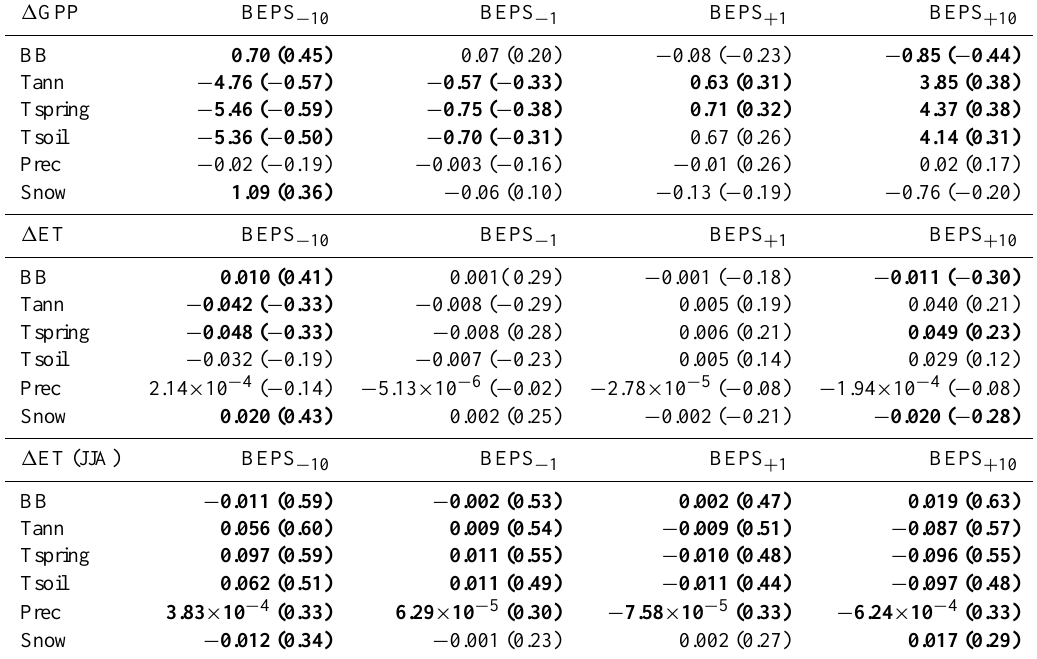
Table 5. Slope of the linear regression analysis computed between 1 GPP, 1 ET and summertime 1 ET (from June to August) and different meteorological variables. In parentheses the Pearson’s correlation coefficient is reported. The differences of GPP ( 1 GPP) and ET ( 1 ET) are computed as the differences in annual GPP [gCm − 2 yr − 1 ] and ET [cmyr − 1 ] between the runs BEPS − 10 , BEPS − 1 , BEPS + 1 , BEPS + 10 and the reference run (Table 3). Tann is the mean annual temperature, Tspring is the springtime mean temperature (i.e. from March to May), Tsoil is the mean soil temperature, Prec [mm] is the annual cumulated precipitation and Snow [cm] is the average snow depth. Bold characters represent statistical significant correlations ( p < 0 .